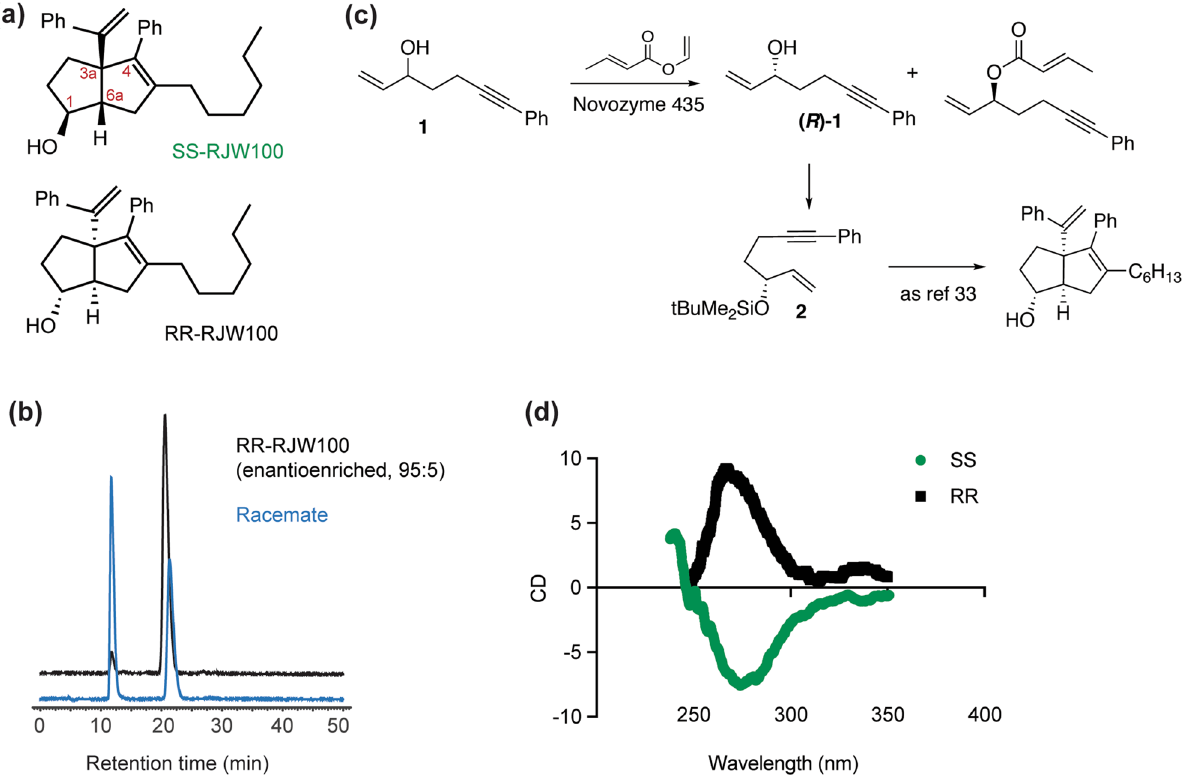
Figure 1. RJW100 enantiomers. ( a ) Chemical structures of SS- and RR-RJW100. ( b ) HPLC traces for RR-RJW100 generated by enantioselective synthesis (black curve) and for the racemate (blue curve). Separation by HPLC resulted in enantiopure RR-RJW100 and SS-RJW100 (both 100% ee). ( c ) Enantioselective synthesis of RR-RJW100. The ( R )-enantiomer of the alcohol 1 was obtained from the racemate by kinetic resolution using a crotylation reaction with Novozyme 435, an immobilized Candida antartica lipase as the catalyst, which is known to be selective for the (S)-enantiomer of alcohols with a similar structure 54 . The reaction was stopped at around 50% conversion. The recovered enantioenriched alcohol (R)- 1 (95:5 enantiomer ratio) protected as the tert -butyldimethylsilyl ether and converted to RR-RJW100 (95:5 enantiomer ratio) using the published procedure for the racemate 33,34 . The enantio-enriched RR-RJW100 was used to identify the two HPLC peaks from the racemate and was not used for experiments with LRH-1/ SF-1. ( d ) CD traces of the RJW100 enantiomers used in these